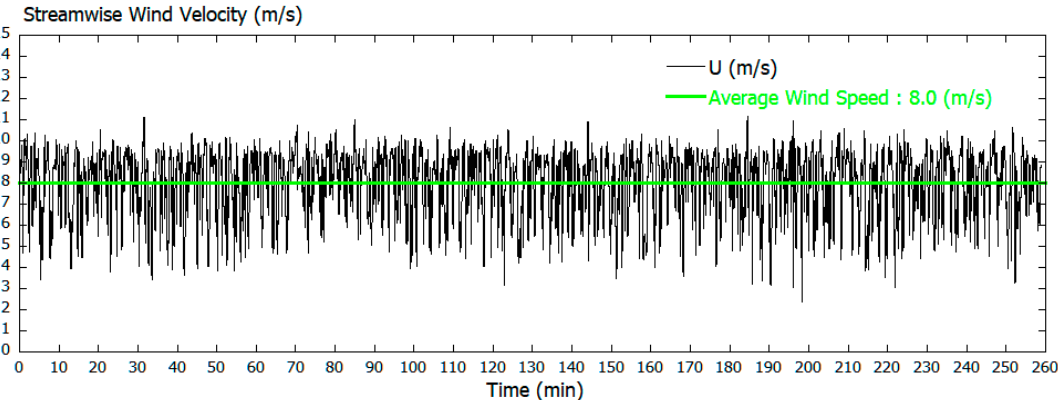
Figure 15. Temporal change of the streamwise (x) wind velocity at the hub height of T7 (60 m above the ground surface) that was rescaled to full scale (m/s).